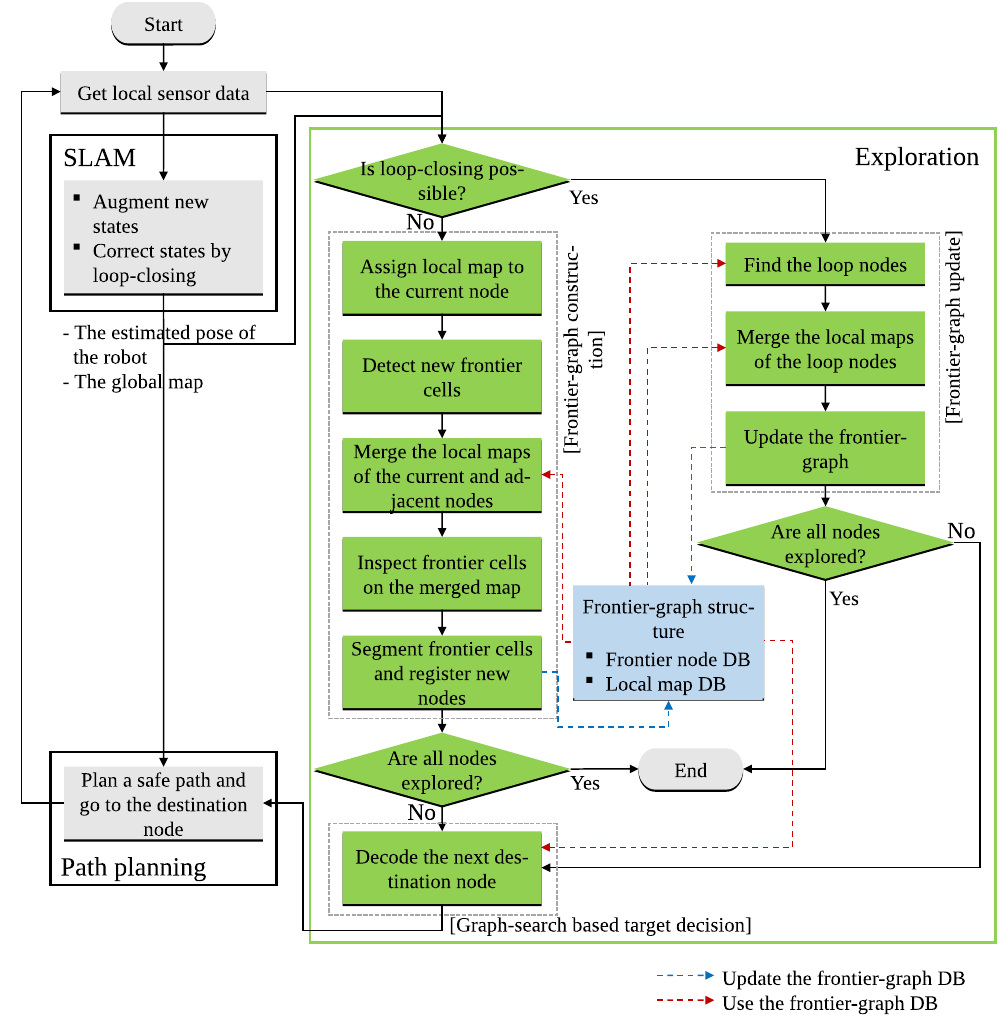
Figure 1. Overview of the proposed integrated exploration algorithm using a frontier-graph structure and graph search-based